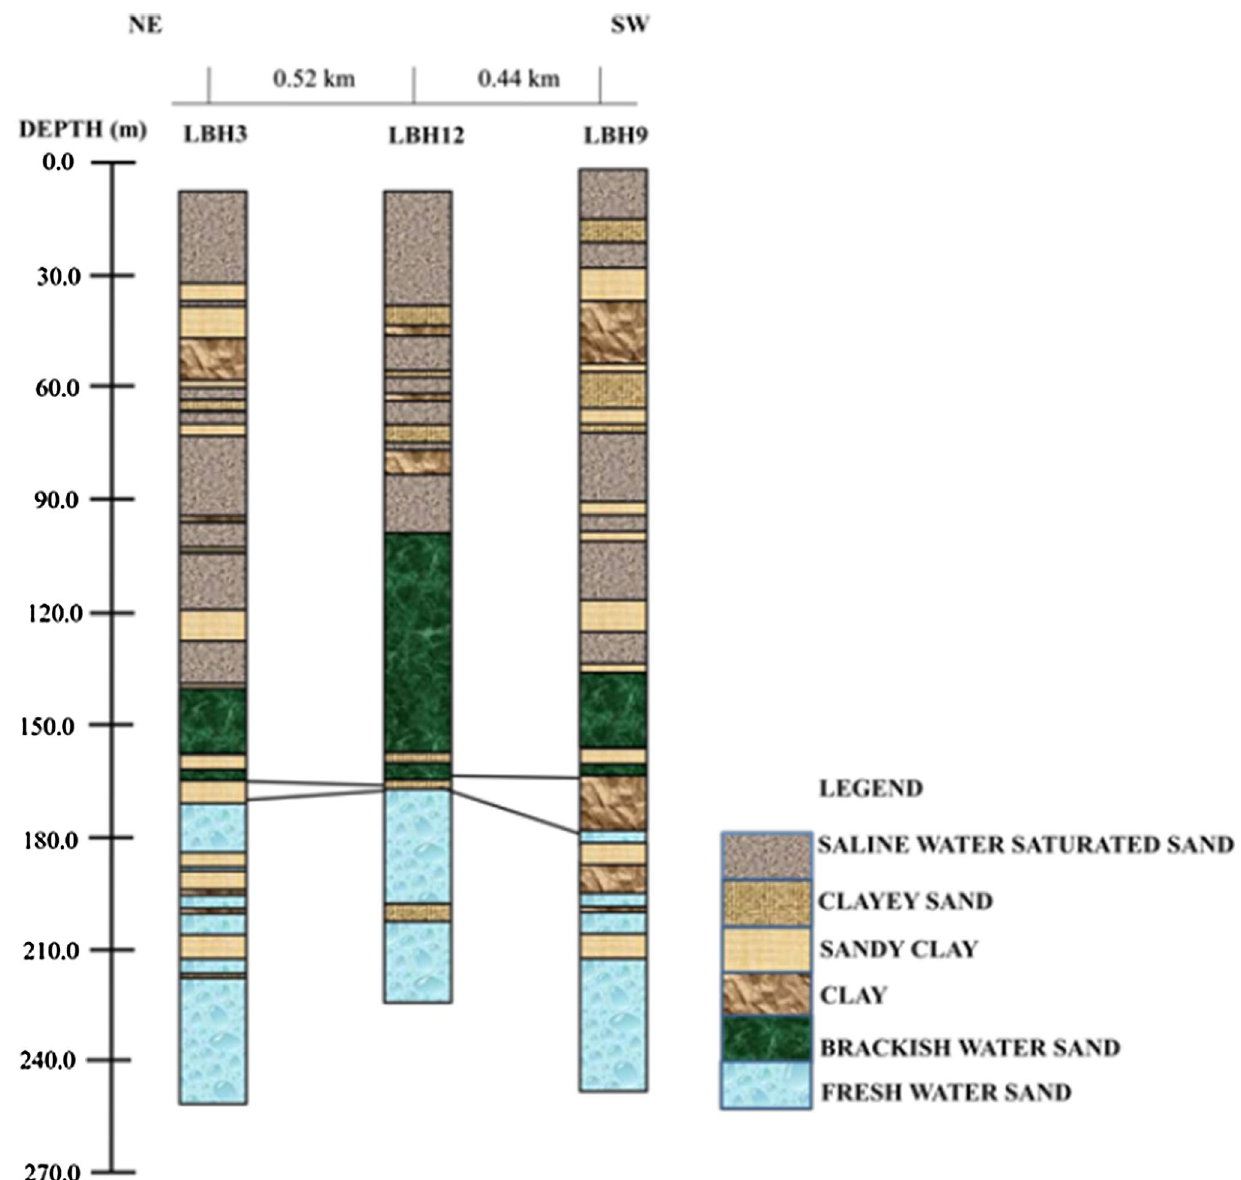
Fig. 8 Correlation panel of geosection E–E ′ showing the occurrence of the end of polluted sand unit and the beginning of freshwater sand